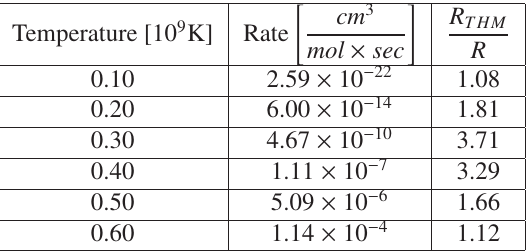
results of [9] ( R ), R THM